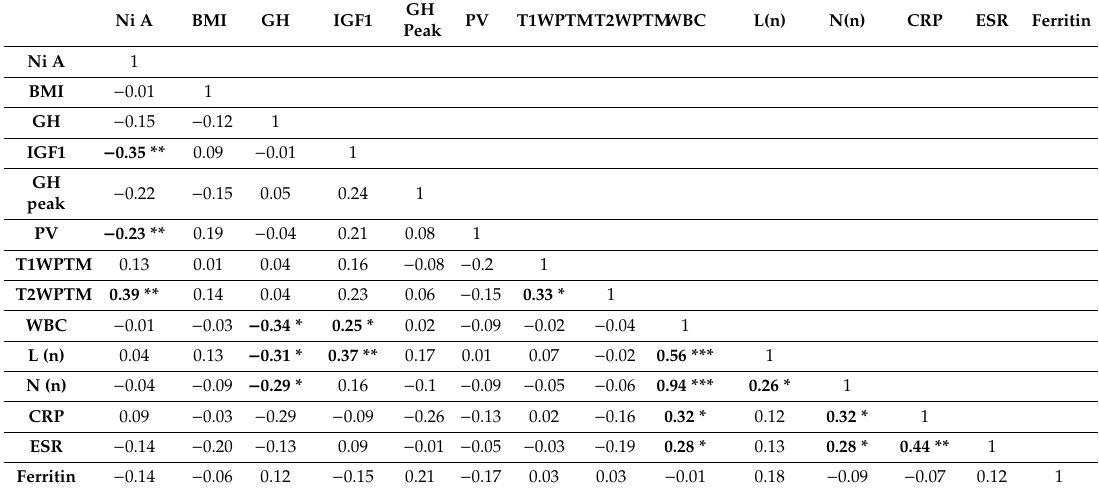
Table 5. Partial correlations between Ni allergy, GH-IGF1 axis, pituitary morphology and inflammatory status parameters after BMI adjustment: correlations are expressed as Pearson correlation coe ffi